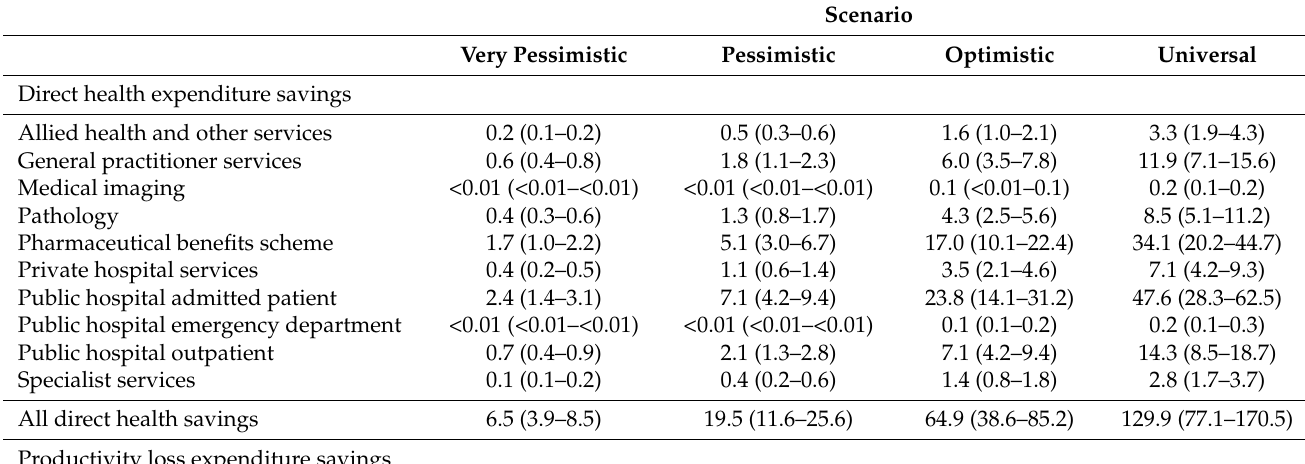
Table 3. Potential annual savings in direct health and productivity loss expenditures of Type 2 Diabetes Mellitus in Australian adults (age 20 and over) from whole grain intakes (AUD million) 1